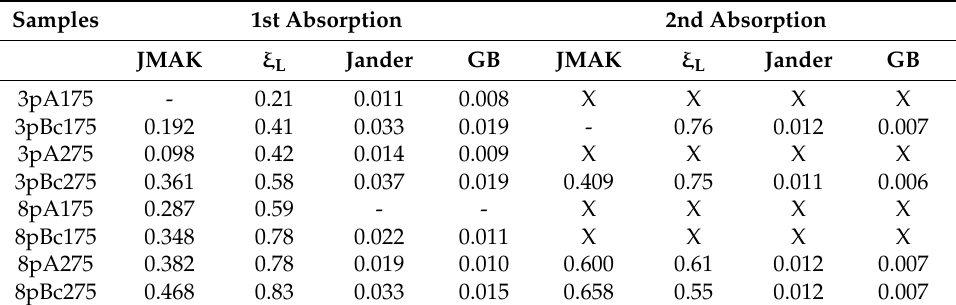
Table 1. The k (H −1 ) parameters and limit values ξ L (%) of the kinetic process after fitting the various traces recorded for the 1st and 2nd hydrogen absorption and for the different ECAP-treated samples.